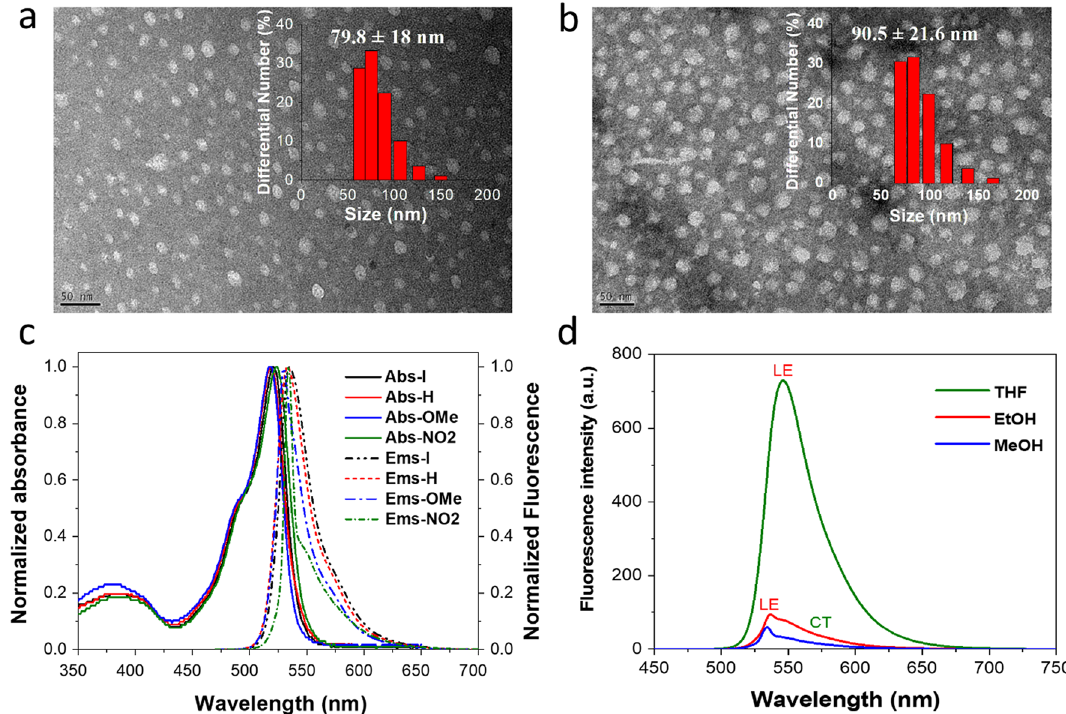
Figure 2. Characterization of BODIPY PSs. TEM images of I - NPs ( a ) and OMe - NPs ( b ) (the scale bar: 50 nm). The inset images indicate the sizes of I-NPs and OMe-NPs based on DLS. The normalized absorption and emission spectra of I, H, OMe , and NO2 in methanolic solution at c = 5 µM ( c ). The emission spectra of BODIPY NO2 in various solvents at c = 5 µM ( d ). The solutions were excited at 490 nm.